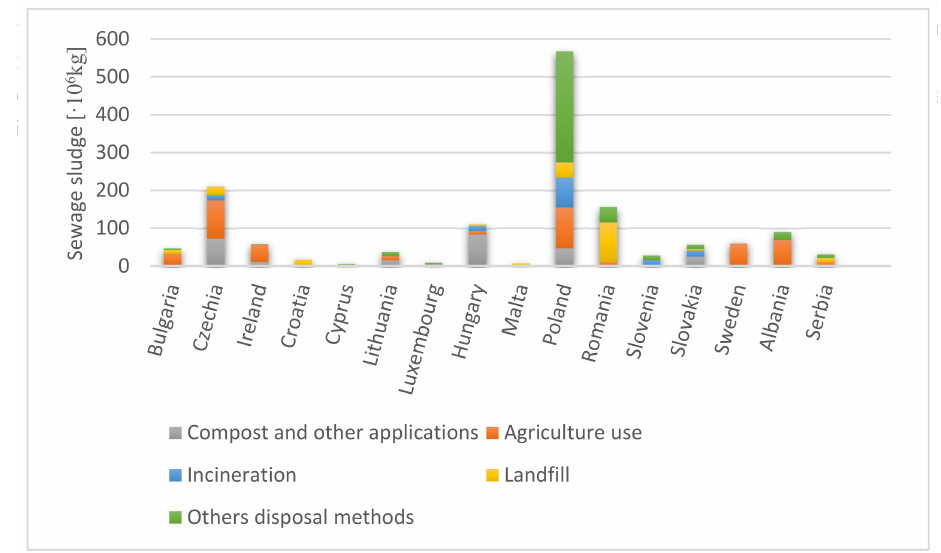
Figure 3. Share of di ff erent methods of disposal of sewage sludge in total disposal in selected European countries in 2015